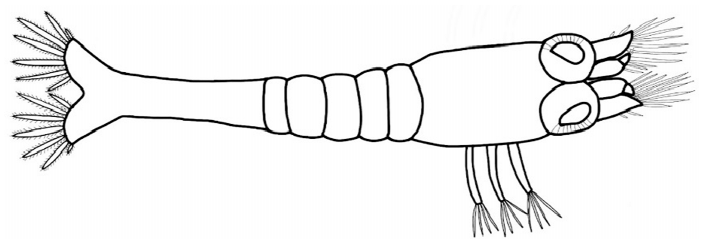
Figure 1. Atya lanipes zoea larvae stage; the organism used in the study.